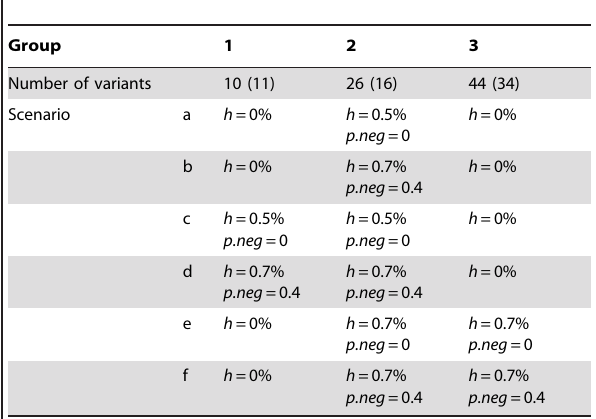
Table 1. Simulations with three groups.